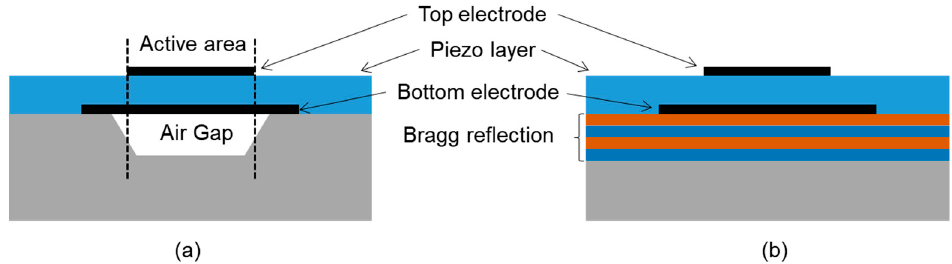
Figure 2. Structure of ( a ) the film bulk acoustic resonator (FBAR) formed over an air gap and ( b ) the solid mounted resonator (SMR) formed over a Bragg reflection layer.